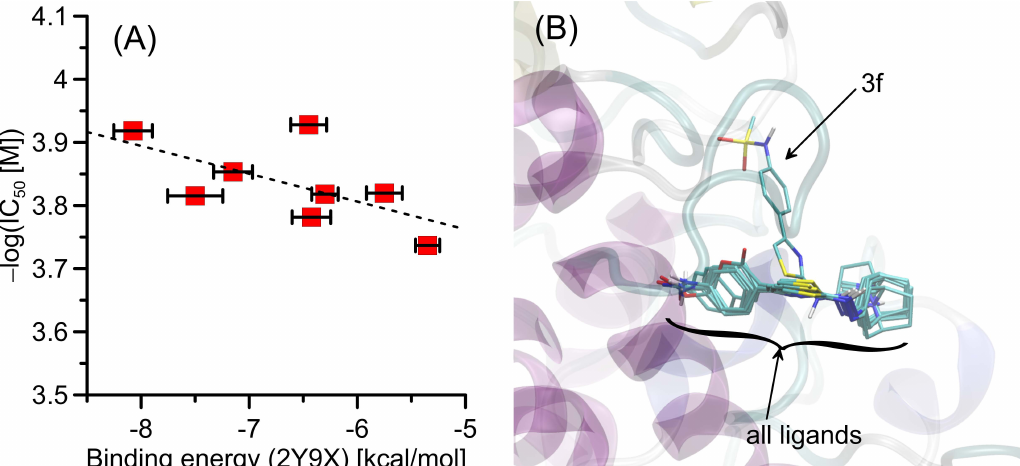
Figure 9. ( A ) The correlation between the binding energies calculated for 2y9x interacting with a set of ligand molecules ( 3a – 3h and ascorbate ion) with the − log(IC 50 ) values. The numerical values can be found in Table 4. ( B ) The superposition of poses of all ligands found during docking study. Compound 3f may exhibit the two alternative poses, only slightly di ff ering by binding energies (see discussion in the